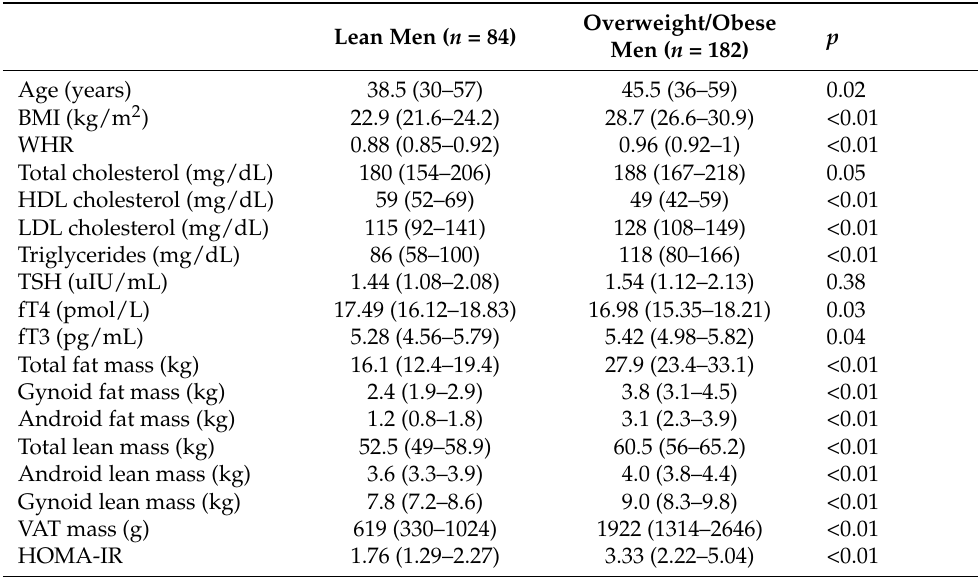
Table 2. Clinical and biochemical characteristics and body composition estimated with DXA method in lean and overweight/obese men.